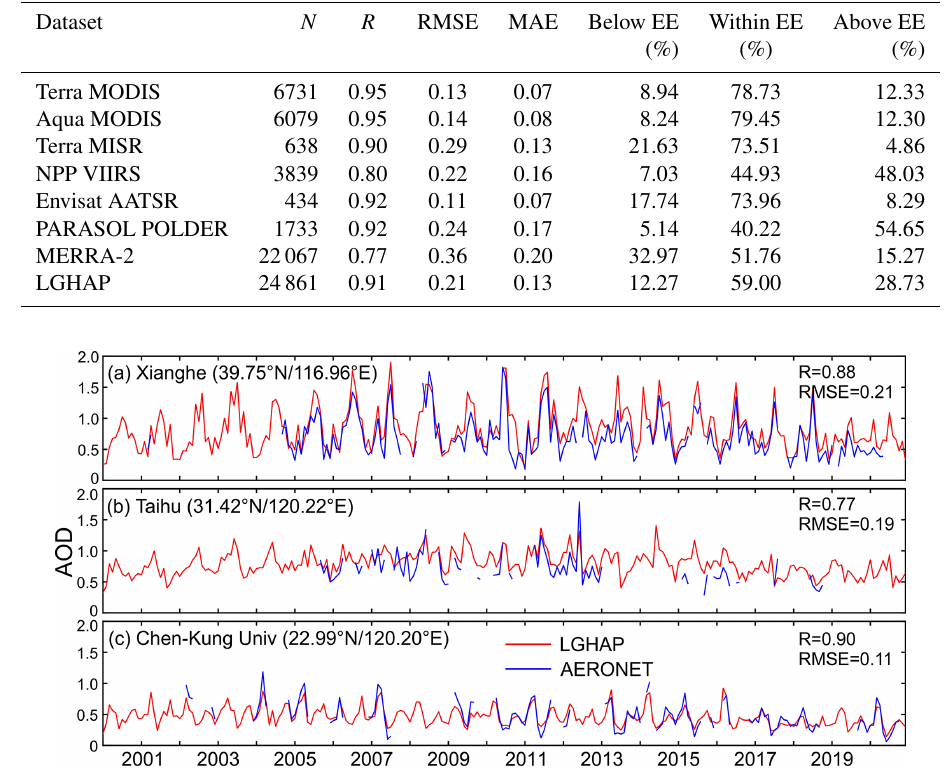
Table 2. Data accuracy of original and gap-free AOD datasets used and/or generated in this study. The expected error (EE) was defined as ± 0 . 05 + 0 . 15 × AOD site . MAE denotes the mean absolute error and was calculated as the absolute value of bias.